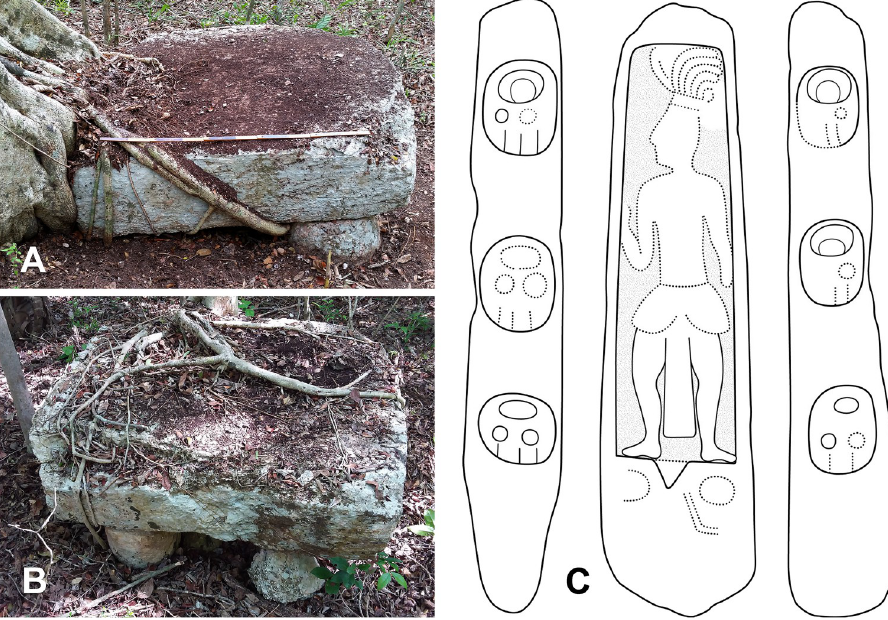
Fig 11. Quadrangular altars on cylindrical supports in groups F10-d (A) and G14-b (B); CHRP Stela 1 (height: 2.08 m, width: 0.52 m, thickness: 0.37 m), showing a local dignitary and a few pseudo-glyphs (C; drawing by Octavio Esparza